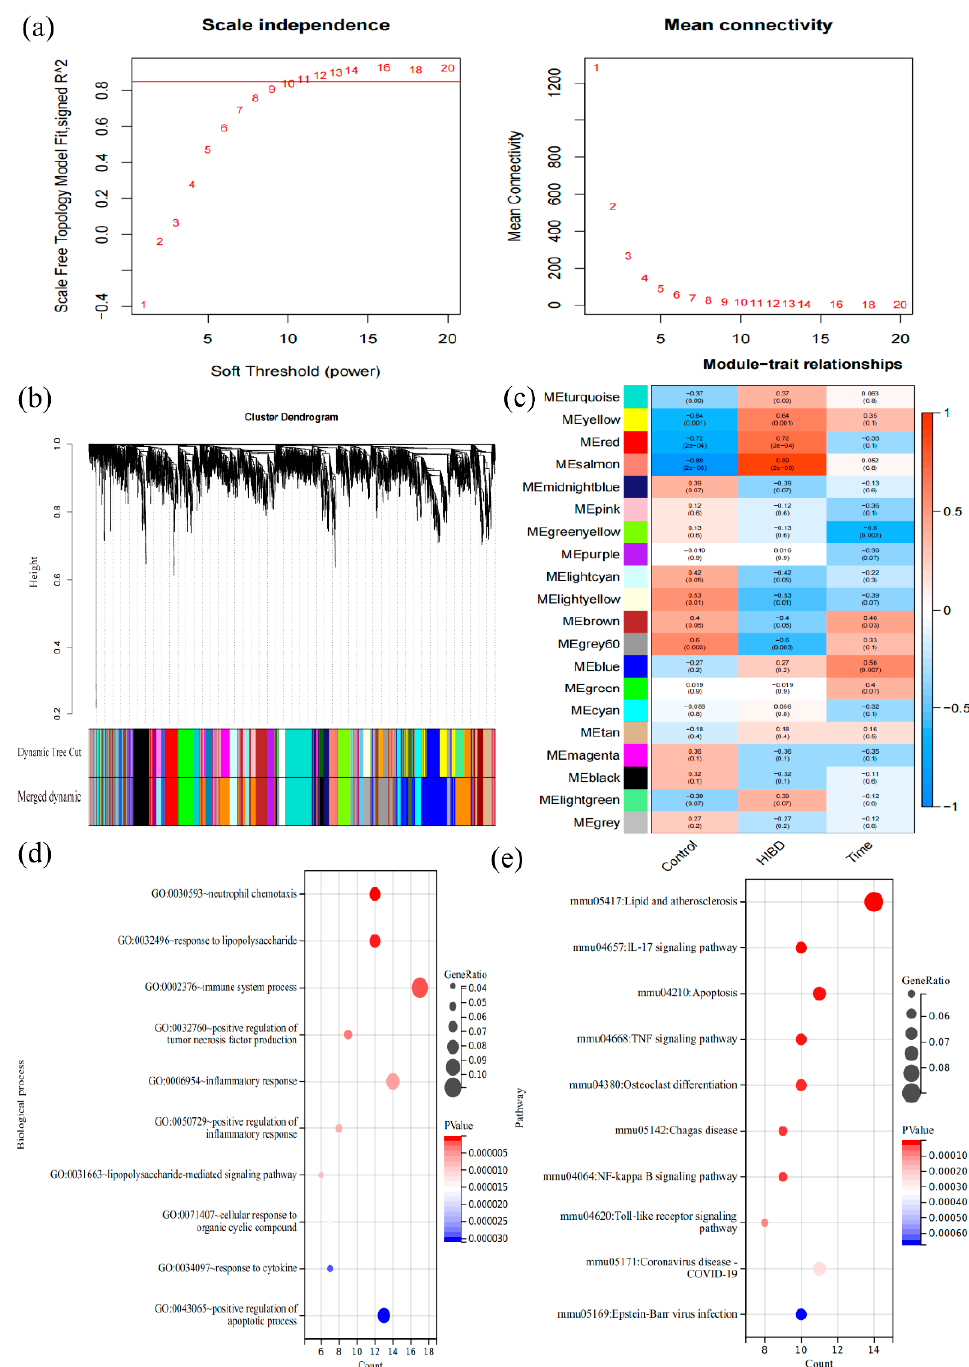
Figure 4. The co-expression modules analysis. ( a ) The relationship between the scale-free fit index and various soft-thresholding powers; ( b ) Clustering dendrogram of genes, various colors represent different modules; ( c ) The relationship of 3 traits and 20 modules; ( d ) Results of enrichment analysis of biological processes; ( e ) Results of enrichment analysis of signal pathways.